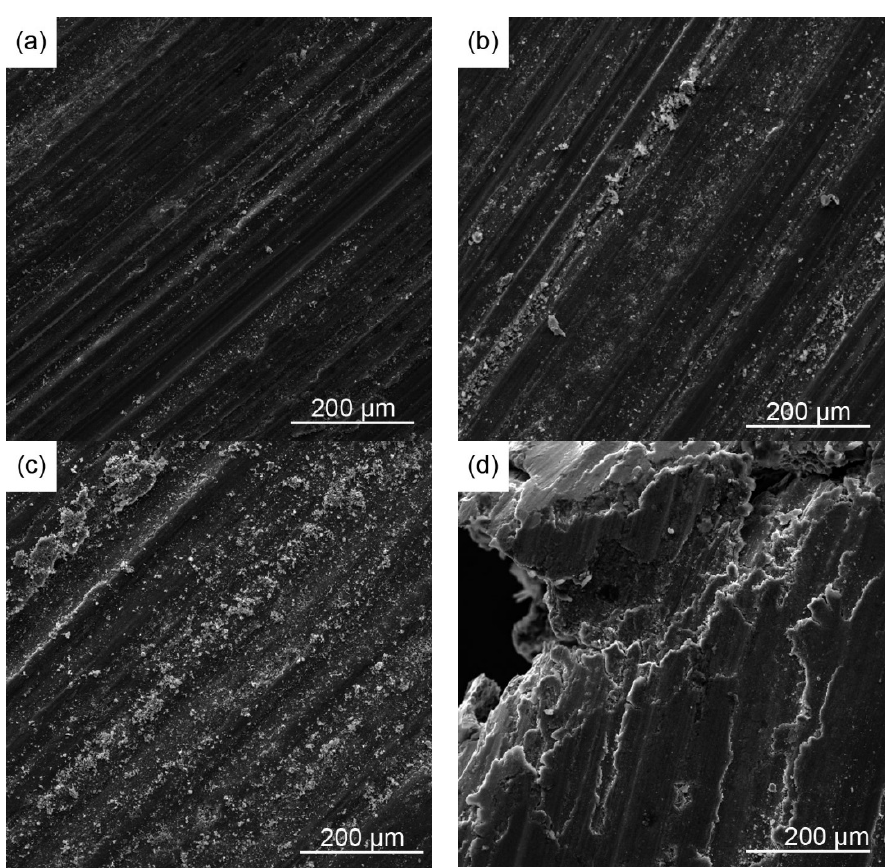
Figure 13. SEM images of SiCp/Al ‐ 5Si ‐ 1Cu ‐ 0.5Mg composites after T6 heat treatment under normal loads of ( a ) 15 N, ( b ) 30 N, ( c ) 60 N; ( d ) edging morphology of the as ‐ cast Al ‐ 5Si ‐ 1Cu ‐ 0.5Mg pin sample at 90 N.